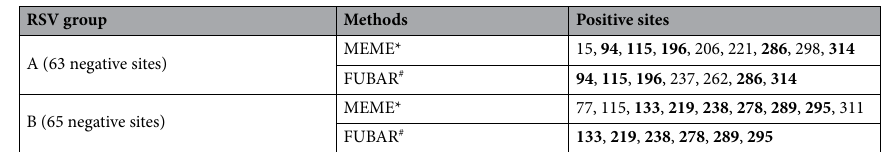
Table 2. Positive selection sites in G gene of RSV-A and -B. Numbers in bold are positive selection sites by both the MEME and FUBAR methods. “*”: p value ≤ 0.05; “ # ”: poster probability of 0.9.